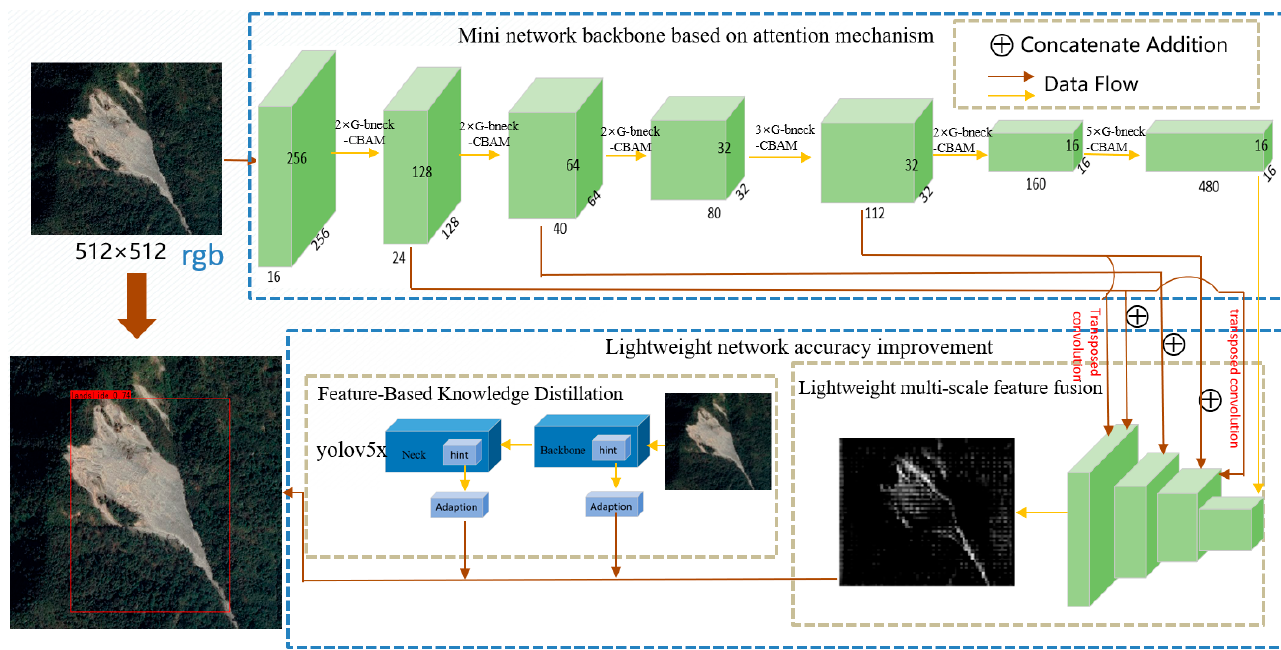
Figure 6. Flow chart of the technology used in this study.